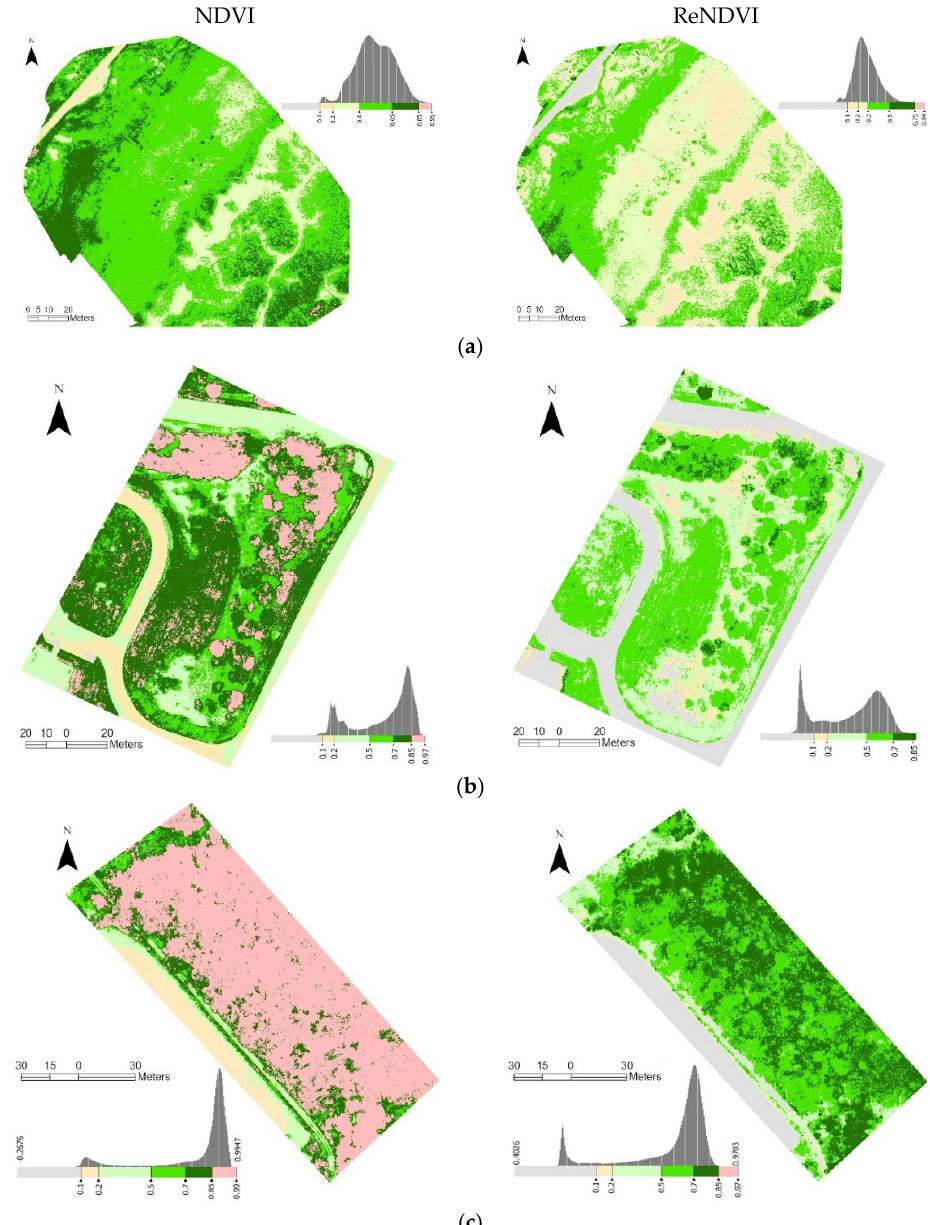
Figure 10. The NDVI and ReNDVI distributions of the RedEdge-M orthoimages for marsh ( a ), grass ( b ), and forest ( c ). The non-vegetation is effectively delineated with ReNDVI > 0.1.